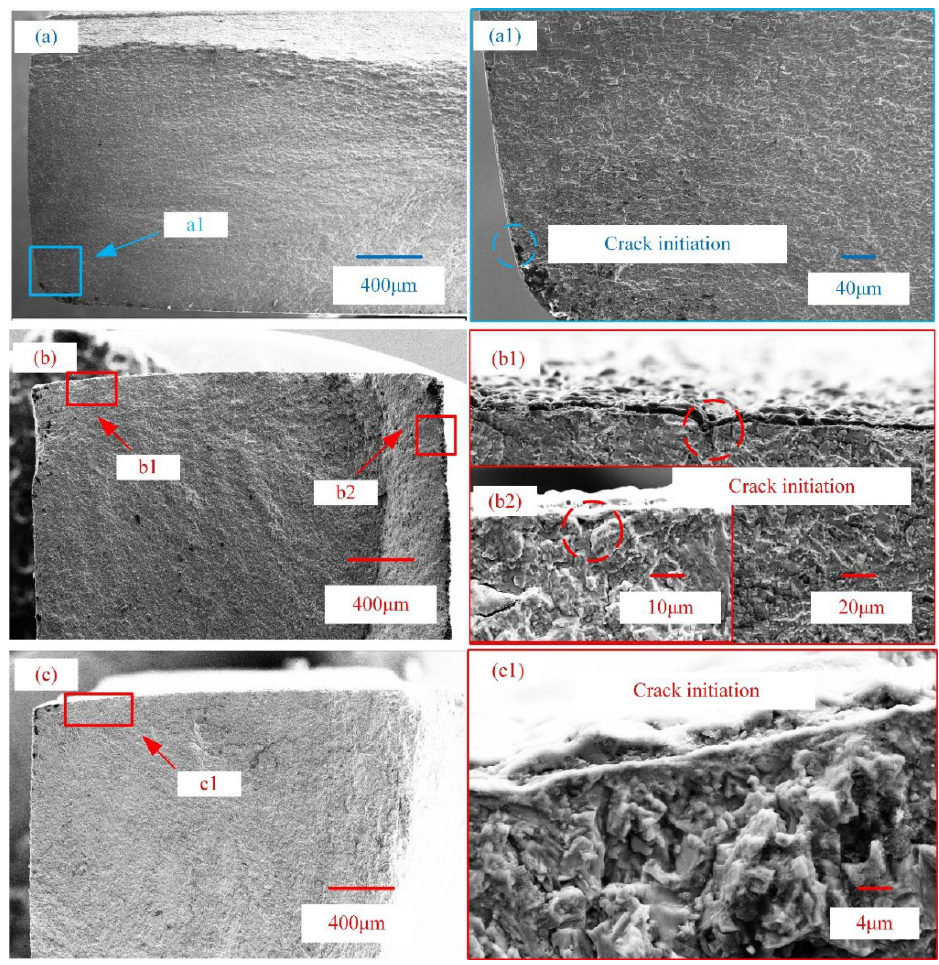
Figure 10. Fatigue morphologies of substrate sample A ( a , a1 ), PEO-coated samples A ( b , b1 , b2 ) and C ( c , c1 ) under 670 MPa. C ( c , c1 ) under 670